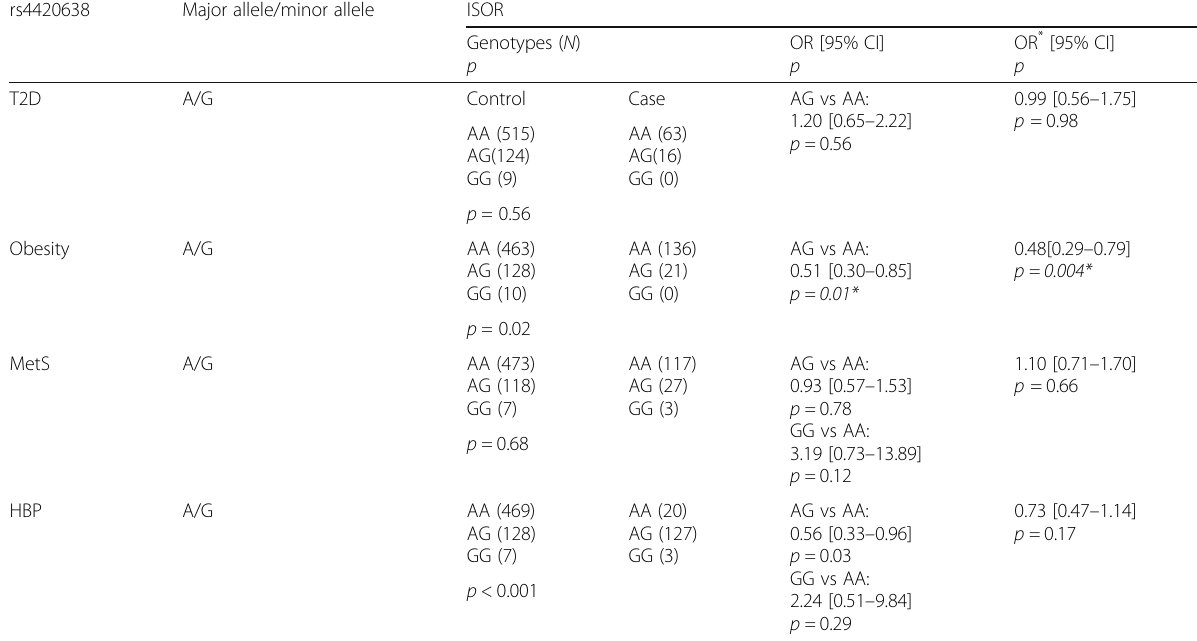
Table 6 APOE rs4420638 polymorphism and cardiometabolic